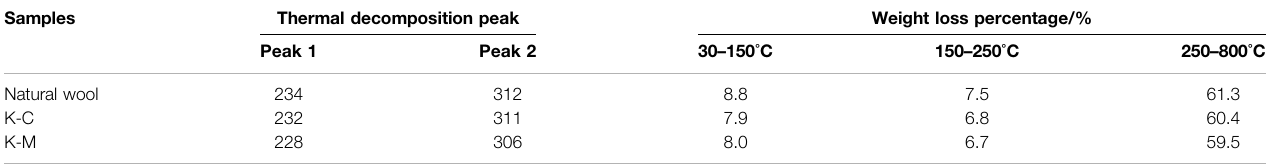
TABLE 5 | Thermogravimetric data of natural wool and wool keratin samples.